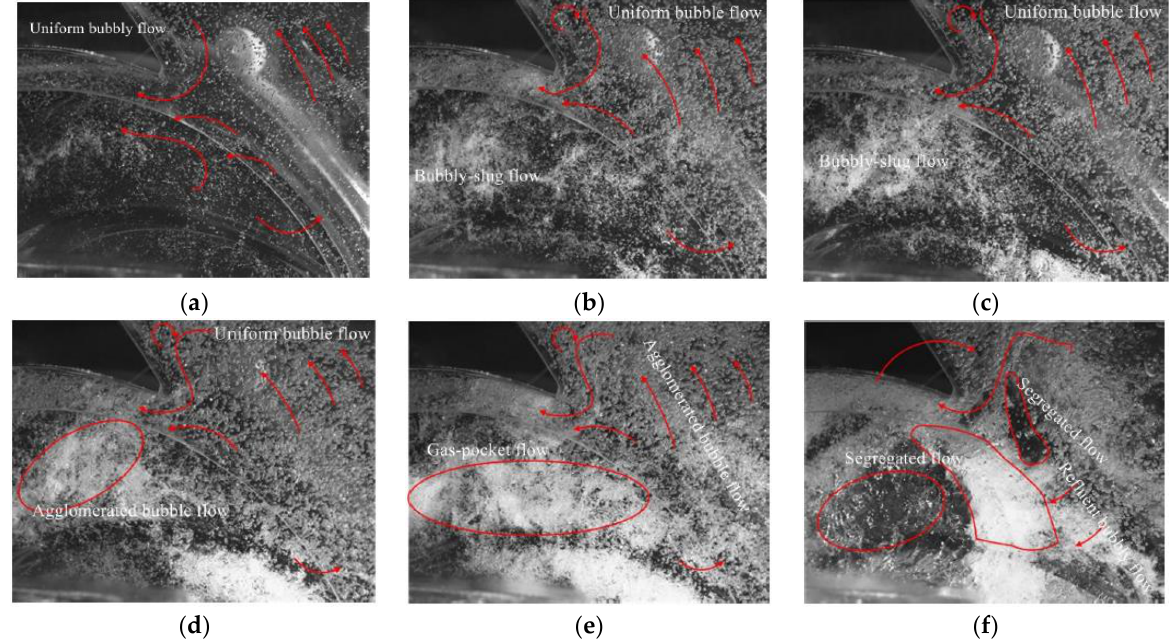
Figure 8. Different flow structures at 𝜑 = 0.06 for inlet air volume fraction (IAVF) [46]: ( a ) 0.5%; ( b ) 1%; ( c ) 2%; ( d ) 3%; ( e ) 4%; ( f ) 4.2%, shut-off condition.